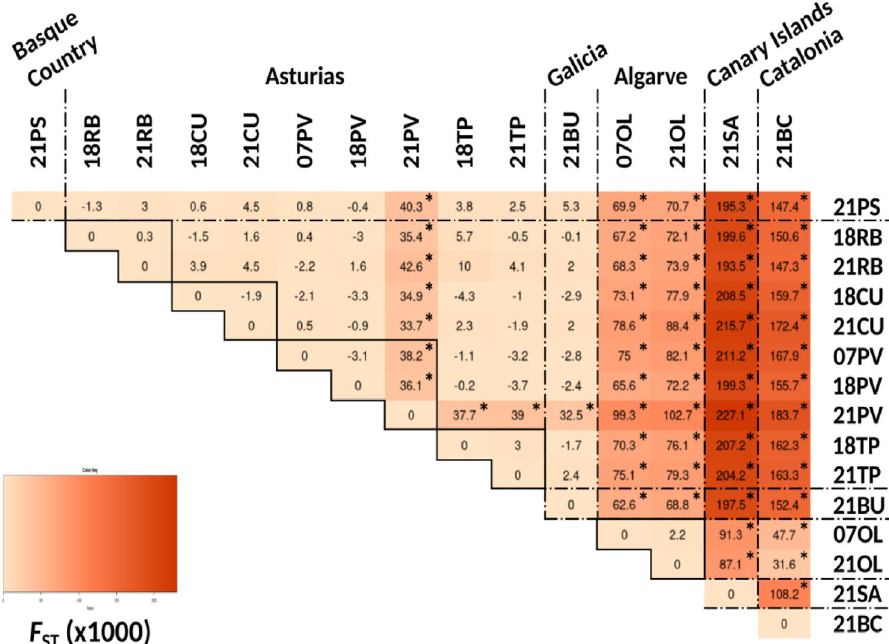
Figure 2. F ST heatmaps (based on Weir and Cockerham 55 ) following genetic analyses of O. vulgaris using microsatellites along the Iberian Peninsula and the Canary Islands. Labels indicate the fishery season (first two digits) and the locality (Pasaia (PS), Ribadesella (RB), Cudillero (CU), Puerto de Vega (PV), Tapia de Casariego (TP), Bueu (BU), Olhão (OL), San Andrés (SA), Barcelona (BC)). The darker the color, the higher the F ST value. Asterisks indicate significant p-values (p < 0.05) after Bonferroni correction. Temporal comparisons are highlighted by black